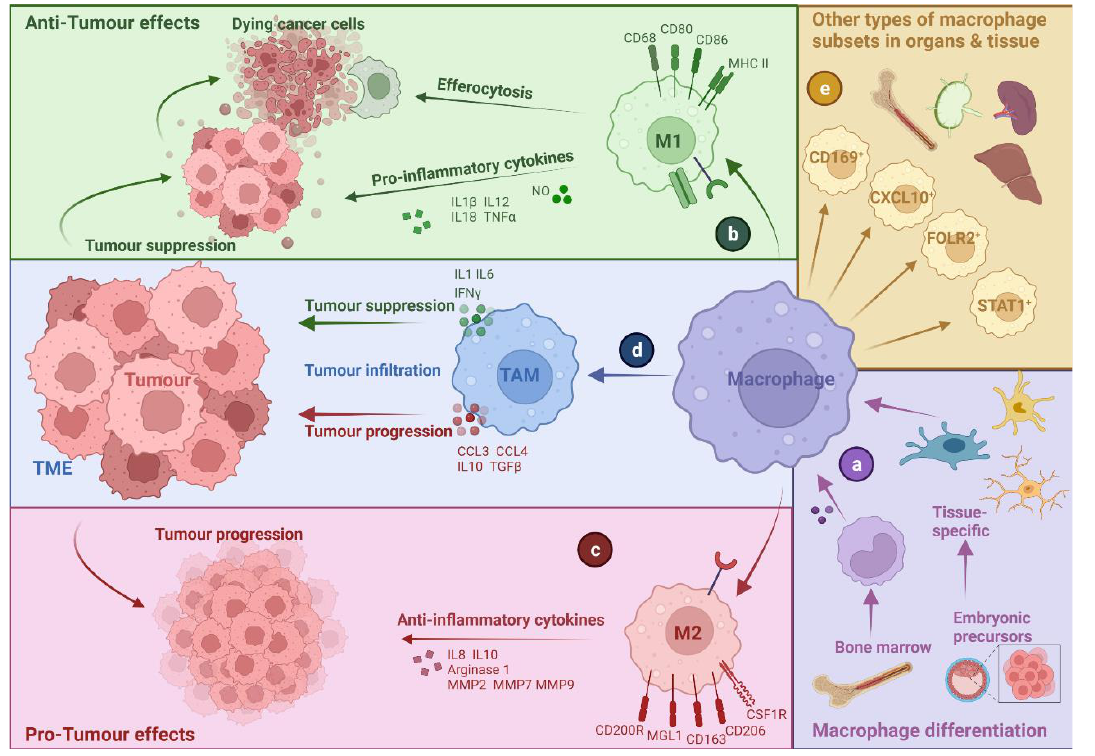
Figure 1. Schematic overview of macrophage development into different classes. Macrophages differentiated from bone marrow and embryonic precursors, different phenotypes will arise according to the tissue origin or organs ( a ). The two main classes of macrophages are classically activated macrophages (M1) and alternatively activated macrophages (M2). Macrophages differentiated into M1-like macrophages express high levels of main histocompatibility complex II (MHC-II) and clusters of differentiation (CD). Once activated, M1-like macrophages can generate nitric oxide (NO) and secrete interleukins (ILs) and tumour necrosis factor α (TNF α ). M1-like macrophages will induce an anti-tumour effect and will interact with dying cancer cells by efferocytosis to recruit more immune cells ( b ). On the contrary, M2-like macrophages express multiple CDs, CSF1-receptor (CSF1R) and macrophage galactose-type lecin-1 (MGL1). Once M2-like macrophages are activated, they can secrete IL8 and IL10, matrixmetalloproteinase-2, -7 and -9 (MMP2, MMP7 and MMP9) and arginase, hereby stimulating tumour progression ( c ). Migration and infiltration of macrophages in a tumour environment give rise to various tumour-associated macrophages (TAMs) subsets. TAMs resemble mostly M2-like macrophages by secreting IL-10, TGF β and C-C motif chemokine ligands 3 and 4 (CCL3 and CCL4). When TAMs act as M1-like macrophages, they will release pro-IL1, IL6 and IFN γ ( d ). Other subtypes of macrophages can occur depending on the stimuli present in specific tissue or organs ( e